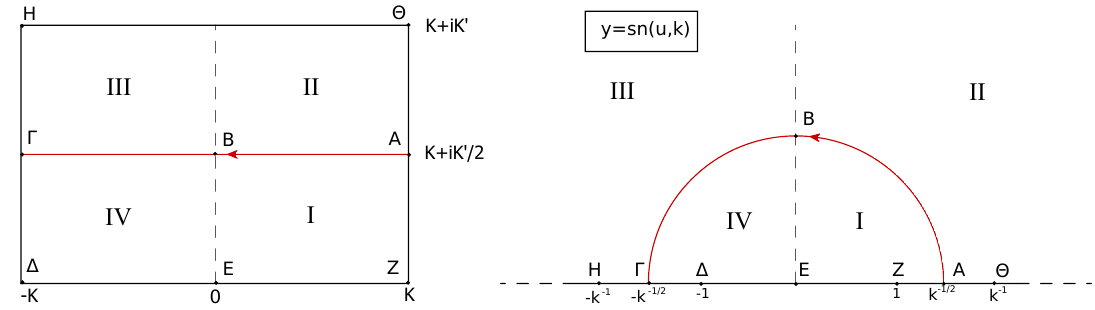
Figure 20 . The mapping of the rectangle to the upper-half plane via y = sn( u; k ), with a matching of corresponding points. The branch cuts are between H (cid:1) and Z (cid:2). Both pictures correspond to the UHP 1 quadrant of (cid:12)gure 21.